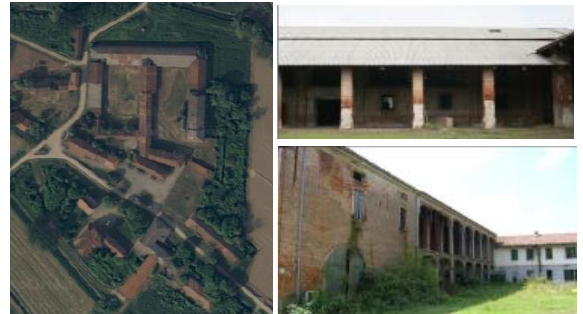
Figure 10 Aerial view of Leri Cavour (left) and two images of the actual state of the main buildings (right).